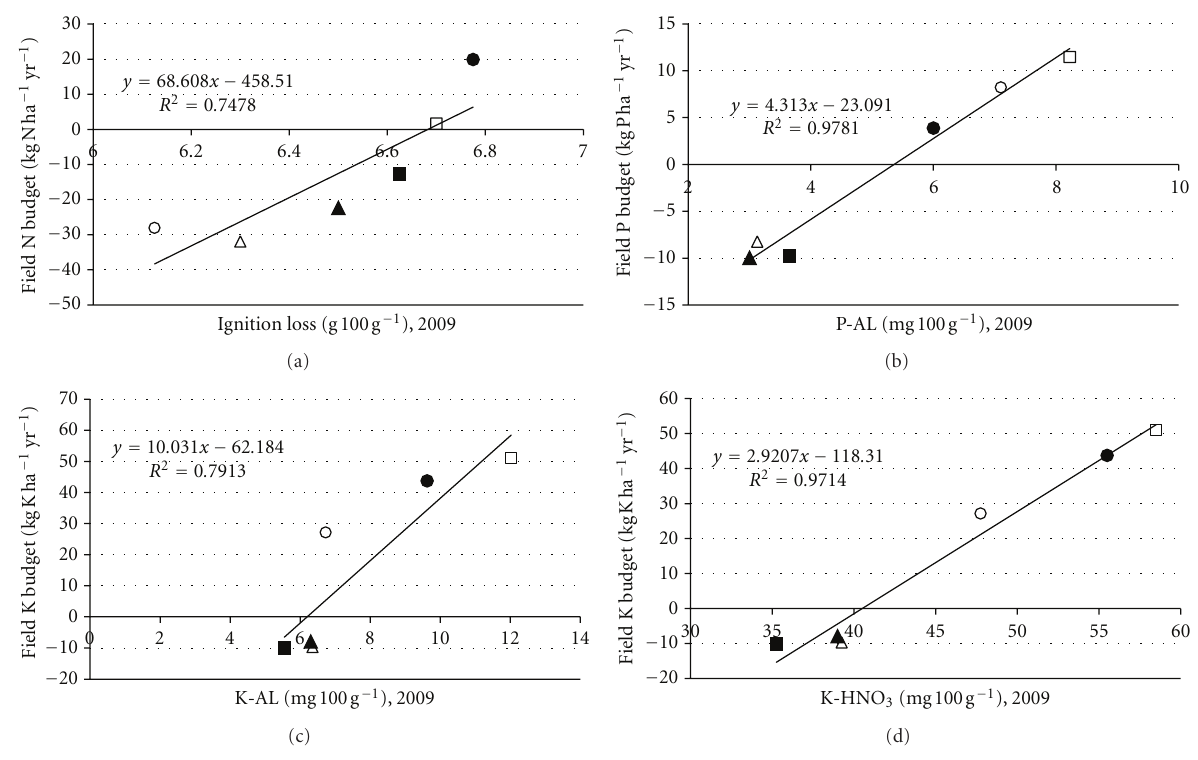
Figure 4: Calculated soil system budgets of N, P, and K for the years 2001–2010 plotted, respectively, against ignition loss (subplot A), P-AL (subplot B), K-AL (subplot C), and K-HNO 3 (subplot D) for the six cropping systems CA1 (conventional arable: (cid:4) ), CA2 (conventional arable, environmentally sound: (cid:2) ), OA (organic arable: (cid:3) ), CM (conventional mixed dairy: • ), OM1 (organic mixed dairy: (cid:4) ), and OM2 (organic mixed dairy with 75% clover ley: (cid:5)